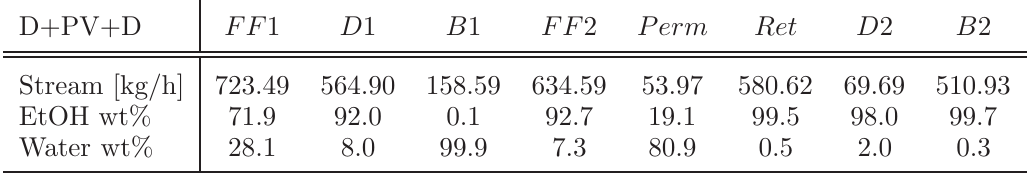
Fig. 8 Distillation followed with pervaporation and another distillation (D+PV+D). Table 6 Technological streams of isothermal pervaporation, D+PV+D.